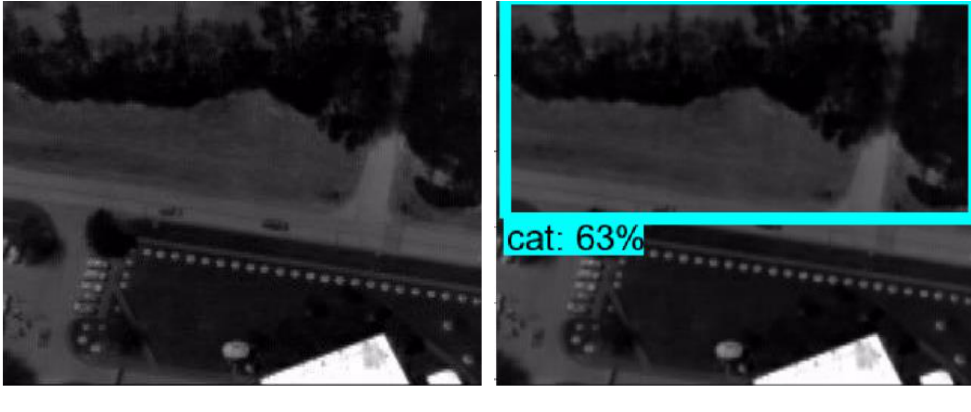
Figure 9. An error case of an object detection method.